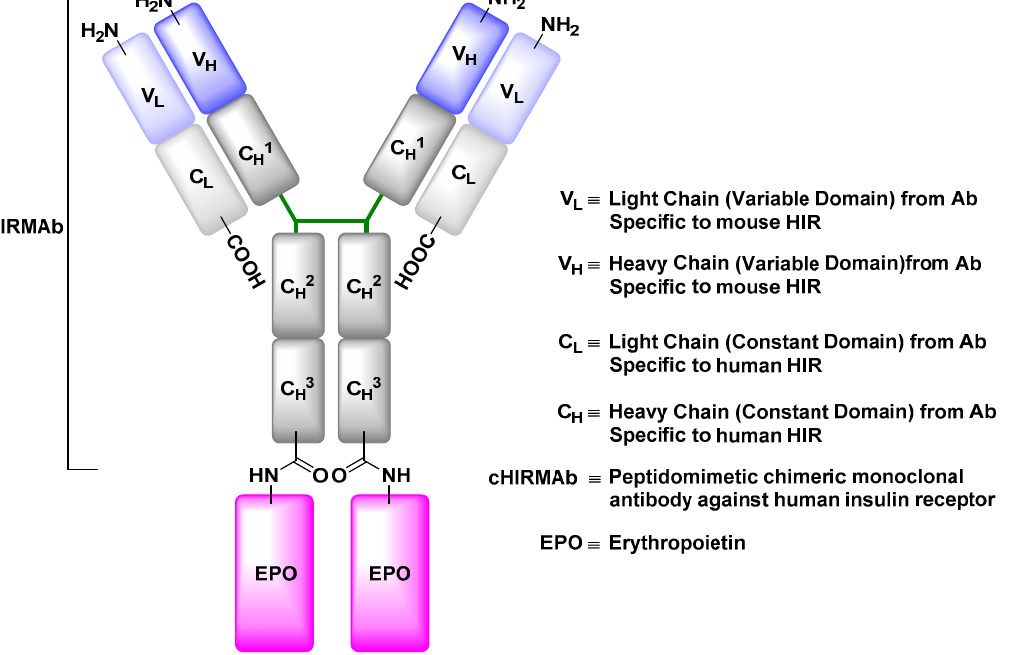
Figure 15. Structure of anti-human insulin receptor monoclonal antibody (HIRMAb) engineered to deliver erythropoietin (EPO) to the brain by exploiting insulin receptor-mediated transcytosis. In this example, the HIRMAb-EPO fusion protein was engineered by fusing the EPO-encoding gene to a HIRMAb expression plasmid. The HIRMAb tandem expression vector encodes the EPO protein linked to the C H3 region of the HIRMAb through its amino terminus.